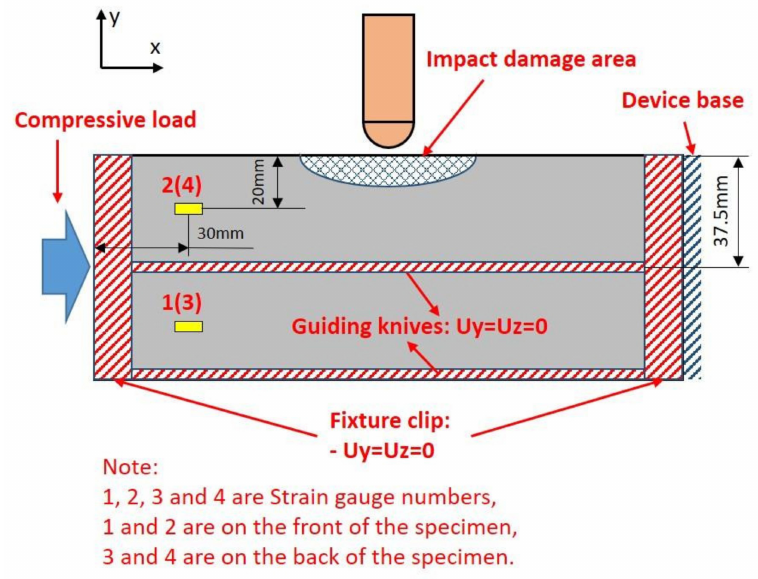
Figure 4. The setup of the compression